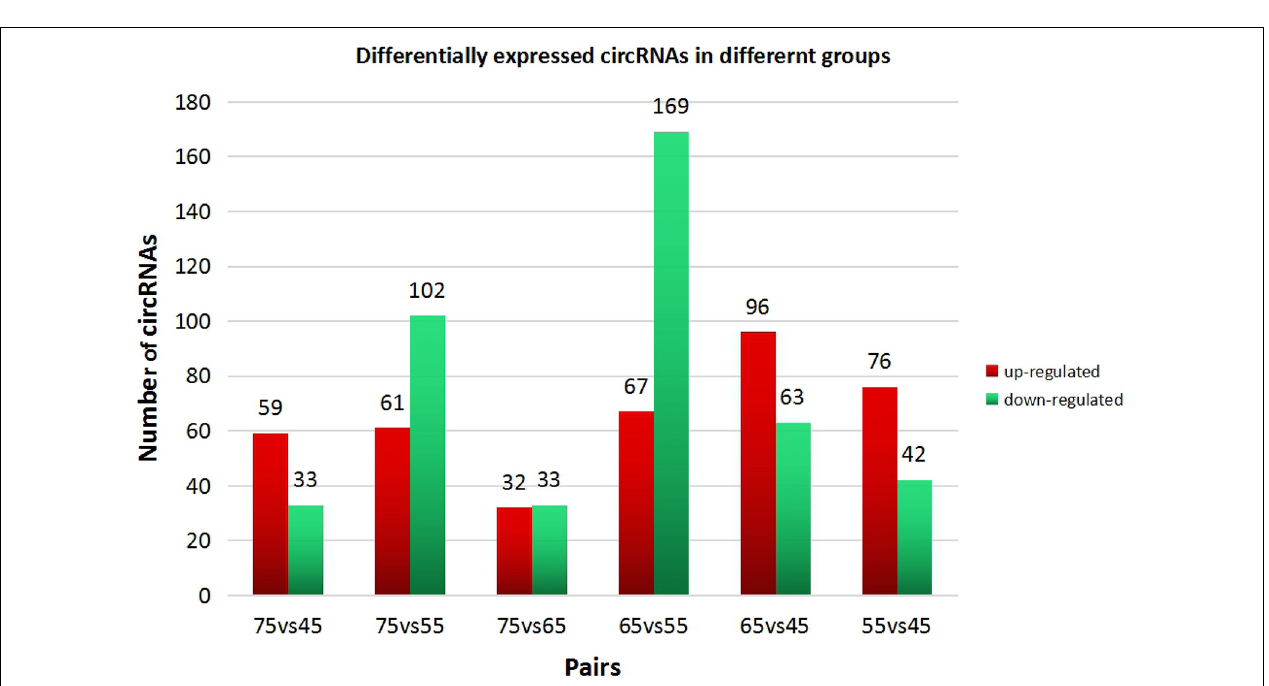
FIGURE 4 | Differential expression of circRNAs in different groups. The red columns represent upregulated circRNAs, and the green columns represent downregulated circRNAs.